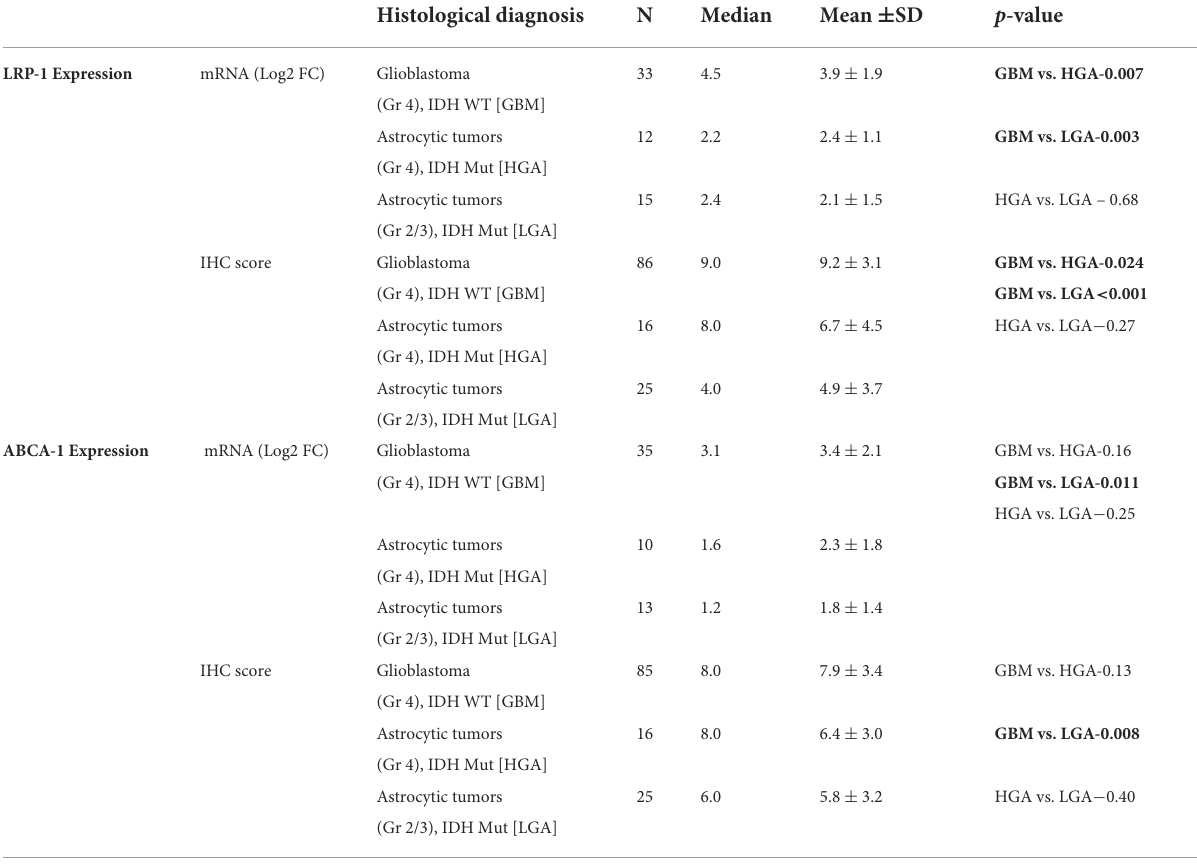
TABLE 2 LRP-1 and ABCA-1 mRNA expression and immunohistochemical expression score in GBM (Gr 4), IDH wild type (WT) and comparison with astrocytic tumors (Gr 4), IDH Mut [HGA] and astrocytic tumors (Gr 2/3), IDH Mut [LGA]. Histological